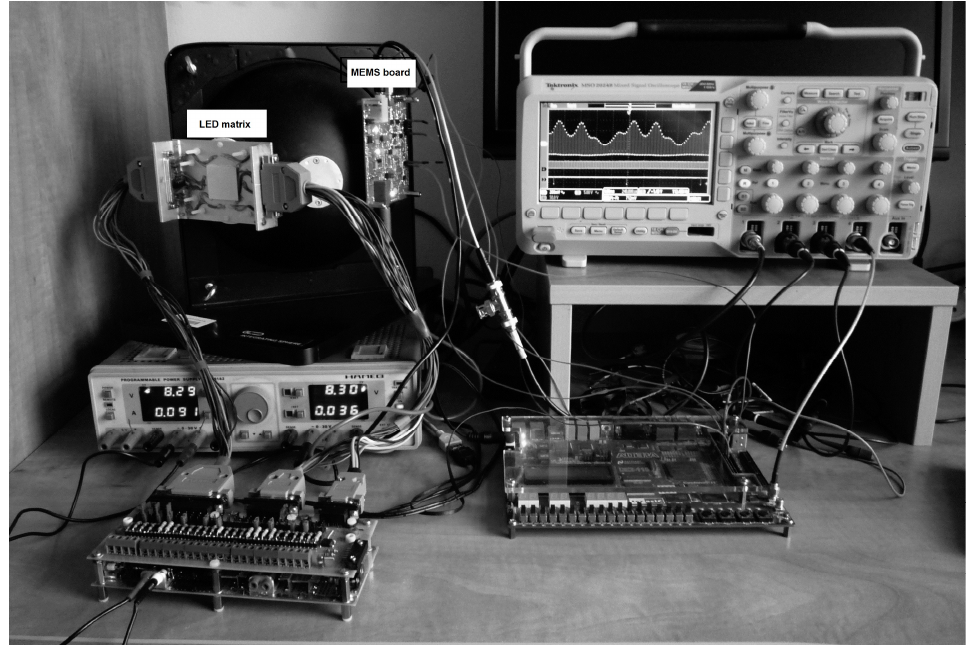
Figure 6. Adaptive LED test platform.